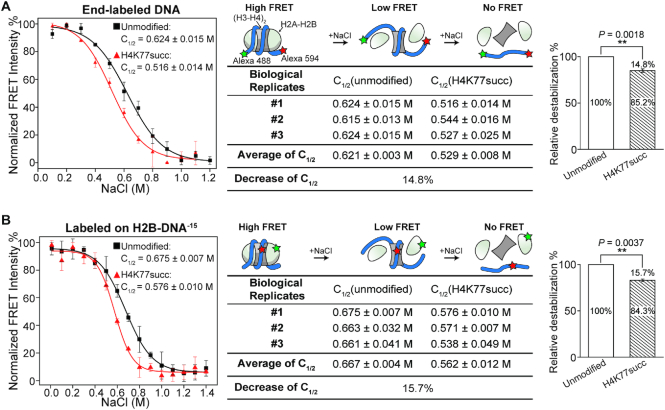
FRET-based approach for studying the effects of histone H4K77succ on nucleosome stability. Plot shows the normalized FRET intensity versus salt concentration in unmodified (black trace) and H4K77succ (red trace) nucleosomes labeled by FRET pairs at DNA ends (A) and H2B-DNA−15 (B). The salt concentration at which the FRET decreases by 50% is denoted as C1/2. For visualization, all curves were normalized between 100% at the maximum FRET value and 0 at high salt concentration. Left panel, a representative salt titration plot of the unmodified and H4K77succ nucleosomes. Salt titrations were repeated three times on nucleosomes from one preparation (n = 3, C1/2 = mean ± s.e.m). Middle panel, the cartoon indicates the relative locations of labels on the nucleosome and the process of salt-induced nucleosome dissociation. The C1/2 values of independent experiments in each type of nucleosome are showed. The average of C1/2 (mean ± s.e.m.) was calculated from three biological replicates (independent nucleosome preparations). The decrease in C1/2 value was calculated as \documentclass[12pt]{minimal}
\usepackage{amsmath}
\usepackage{wasysym}
\usepackage{amsfonts}
\usepackage{amssymb}
\usepackage{amsbsy}
\usepackage{upgreek}
\usepackage{mathrsfs}
\setlength{\oddsidemargin}{-69pt}
\begin{document}
}{}$( {{{{C}}_{1/2}}( {{\rm{unmodified}}} ) - {{{C}}_{1/2}}( {{\rm{H}}4{\rm{K}}77{\rm{succ}}} )} )/{{{C}}_{1/2}}( {{\rm{unmodified}}} ) \times {\rm{\ }}100{\rm{\% }}$\end{document}. Right panel, histogram shows the change in nucleosome stability associated with succinylation modification. The mean of the C1/2 values of unmodified nucleosomes was set to 100%. The P values were based on a two-tailed Student's t test. **P < 0.01.